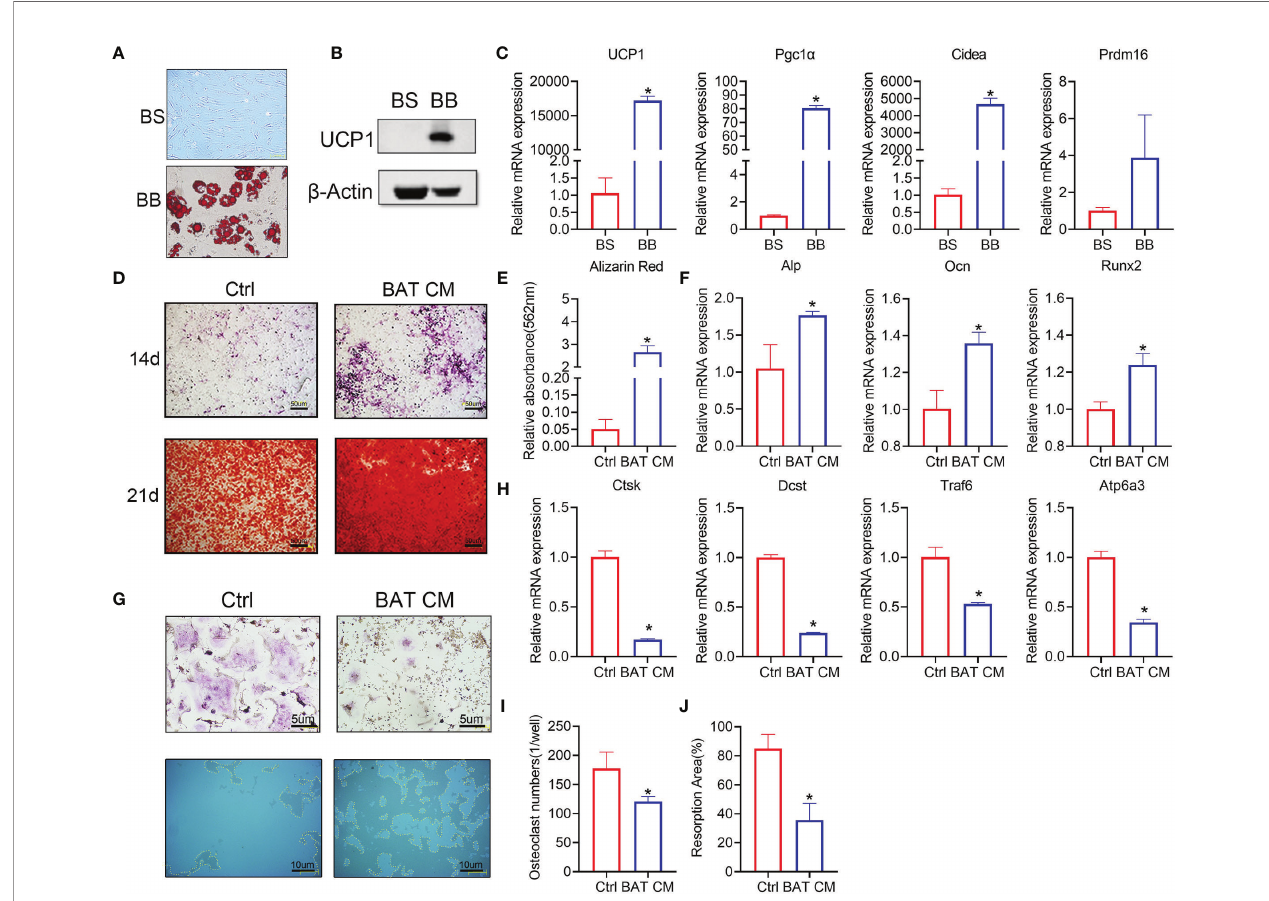
FIGURE 4 | Brown adipocytes affect bone remodeling in vitro . (A) Oil red O staining was performed to show the distribution of lipid droplets in brown adipocytes. (B) Western blot analysis showed that UCP1 expression was higher in the differentiation group. (C) RT-PCR shows the relative mRNA expression levels of the two groups. (D) ALP and alizarin red staining were performed at 14 and 21 days. (E) Semiquantitative analysis of alizarin red staining. (F) Alp, Ocn and Runx2 expression levels are shown. (G) TRAP staining (top) and bone resorption ability (below) in the hydroxyapatite covered plate are shown. Absorbed areas are circled with yellow dotted lines. (H) Relative expression levels of Ctsk, Dcst, Traf6, and Atp6a3 were detected by RT-PCR. (I) Osteoclast numbers in each well are calculated. (J) The osteoclast resorption area in the osteoassay stripwell plate was computed. Data are shown as the mean ± SD (n ≥ 3 per group). Signi fi cance (p-value) was calculated using Student ’ s t-test, *p < 0.05; 1 day (1 d), 14 days (14 d), 28 days (28 d), Normal: mice at room temperature (23°C), Cold: mice at